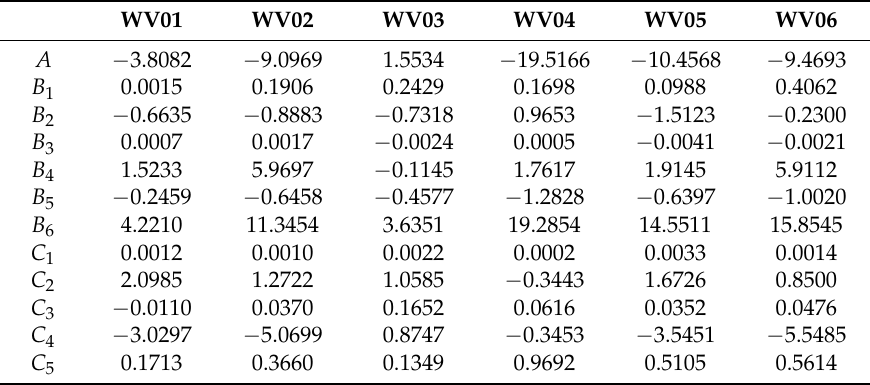
Table 2. Coefficients for QPCWAVE_GF3